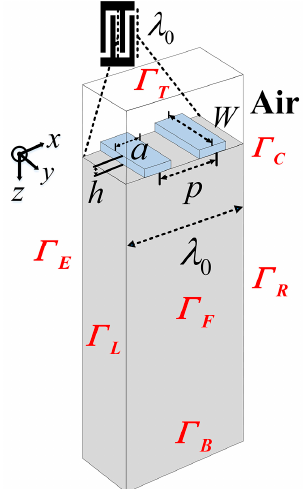
Figure 3. The schematic of the periodic electrodes covering a piezoelectric substrate model. Table 1. Material constants for quartz and Al.